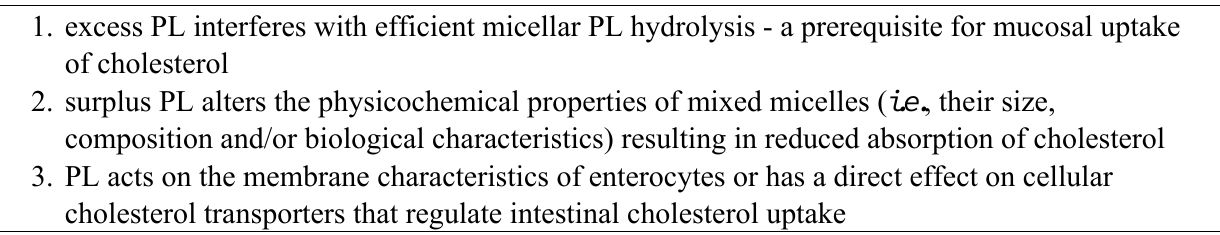
Table 2. Possible mechanisms for inhibition of cholesterol absorption by